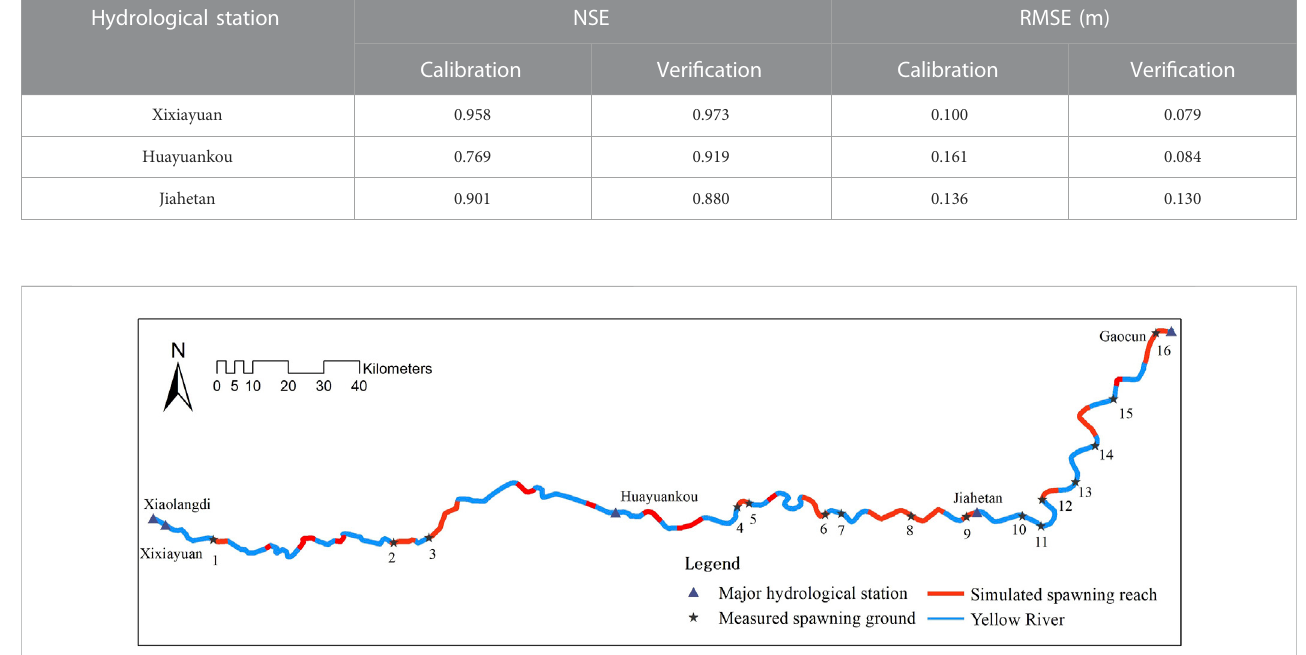
FIGURE 5 PredictedspawninggroundmapbythehabitatsuitabilitymodeloftheYellowRivercarpinthereachfromXiaolangditoGaocunoftheYellowRiverfrom April 1 to June 30,